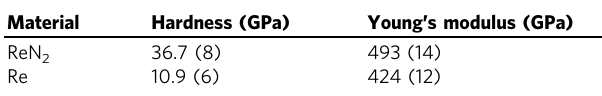
Fig. 2f. Electrical resistivity of metals increases with temperature and this is the case for ReN 2 . The shape of the resistance – temperature curve (Fig. 2f) is reproducible as con- fi rmed in a number of independent measurements on the same sample with re-glued electrical